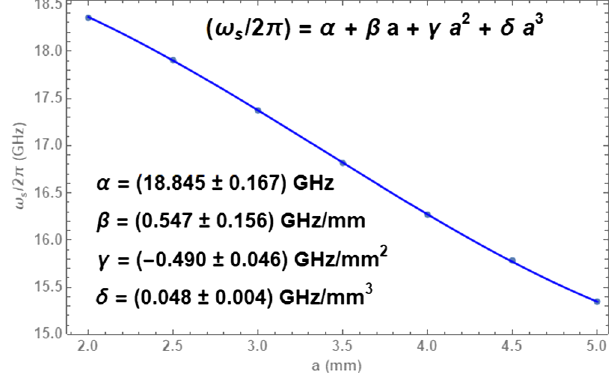
FIG. 8. The synchronous dipole frequencies as a function of the cell radii a . The dots are values found via HFSS simulations and the solid line is the cubic fit.